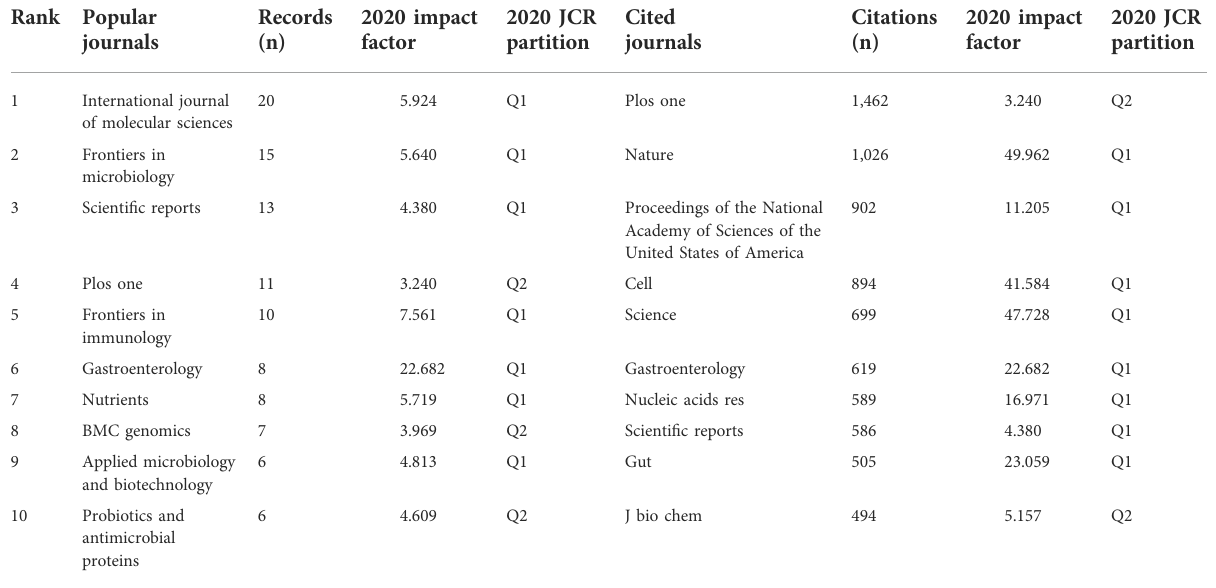
TABLE 1 Top 10 popular journals and cited